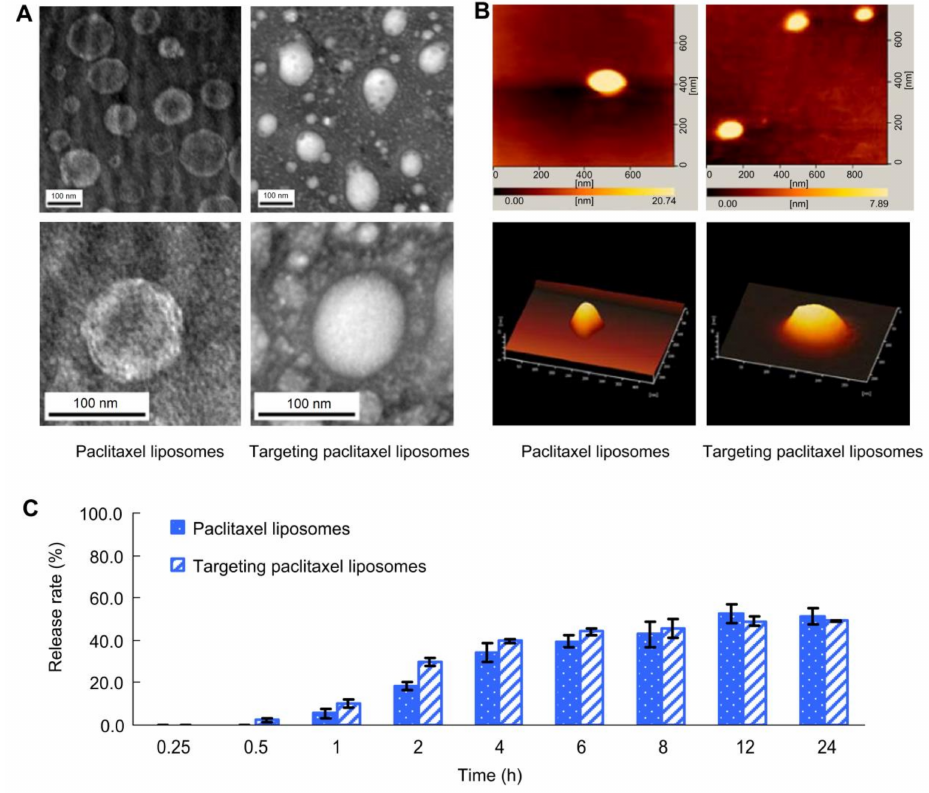
Figure 4. Imaging and release rates of paclitaxel (PCX) liposomes: ( A ) transmission electron microscopy images of PCX liposomes and targeting PCX liposomes, ( B ) atomic force microscopy images of PCX liposomes and targeting PCX liposomes, and ( C ) release rates (%) of PCX-loaded liposomes in the release media of pH 7.4 PBS containing 10% fetal bovine serum (mean ± standard deviation (n = 3). Reproduced with permission